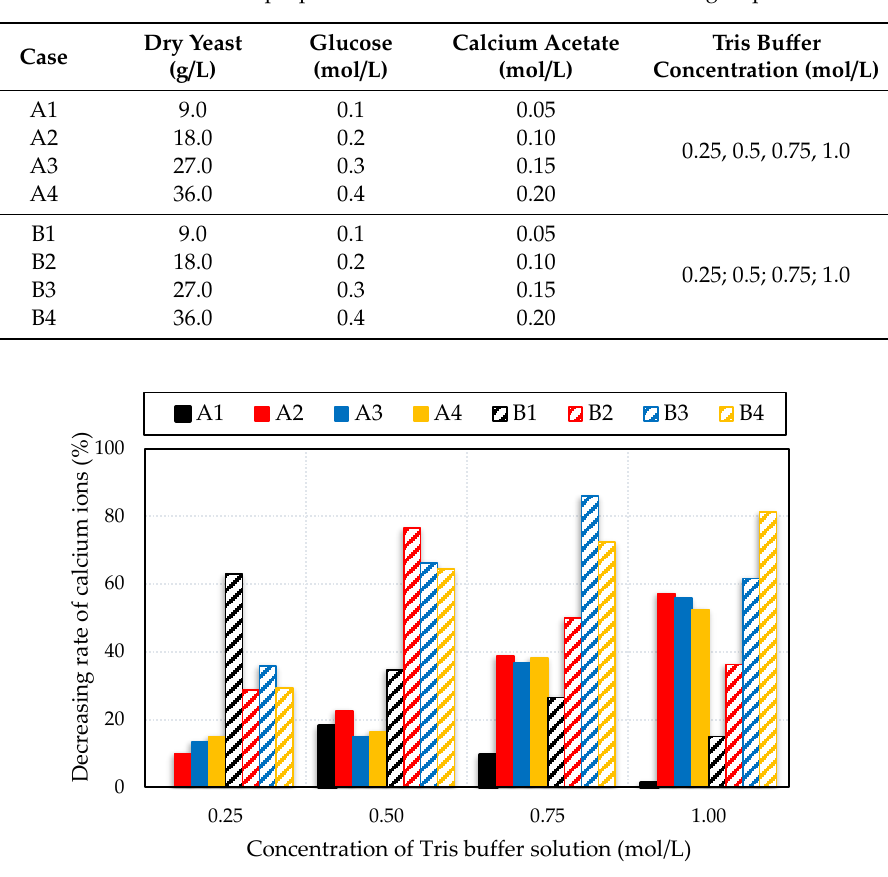
Figure 7. Decreasing rate of calcium ions after 24 h.